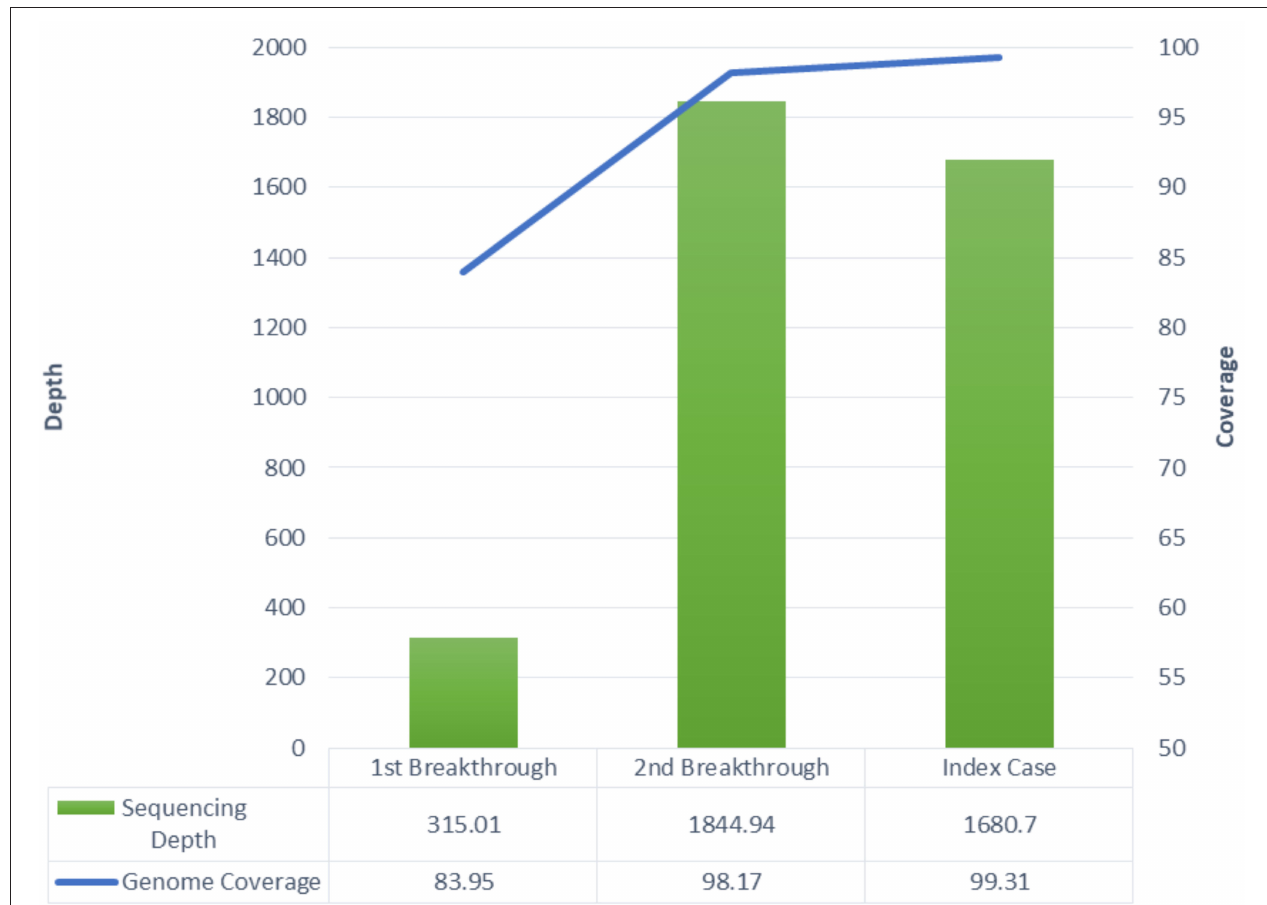
FIGURE 2 | Whole genome sequencing stats including sequencing depth and genome